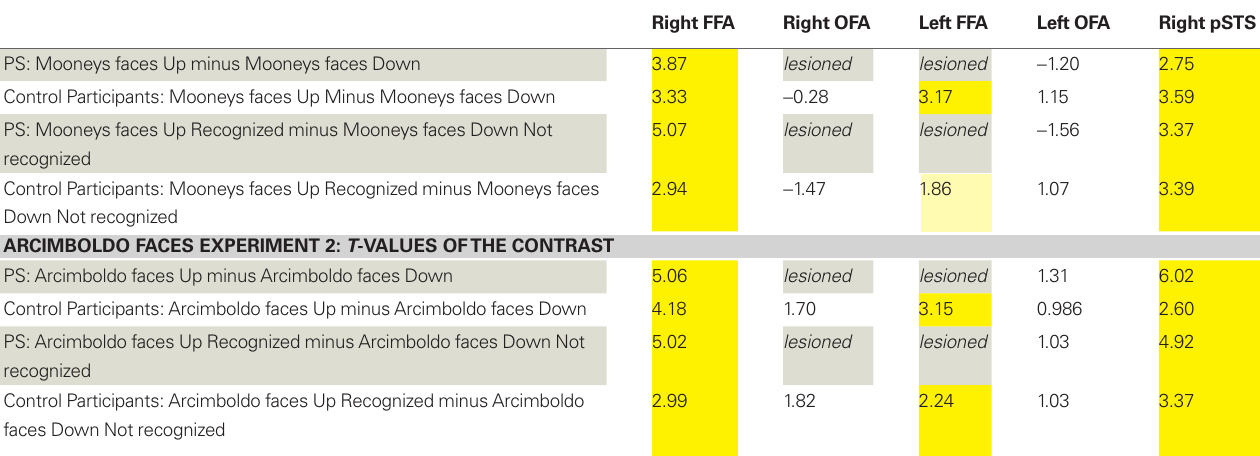
Table 1 | Summary of the statistical significance ( t -values; all p s < 0.05 in yellow) in the regions of interest defined in the functional localizer experiment for the patient PS and the control participants (random analysis).